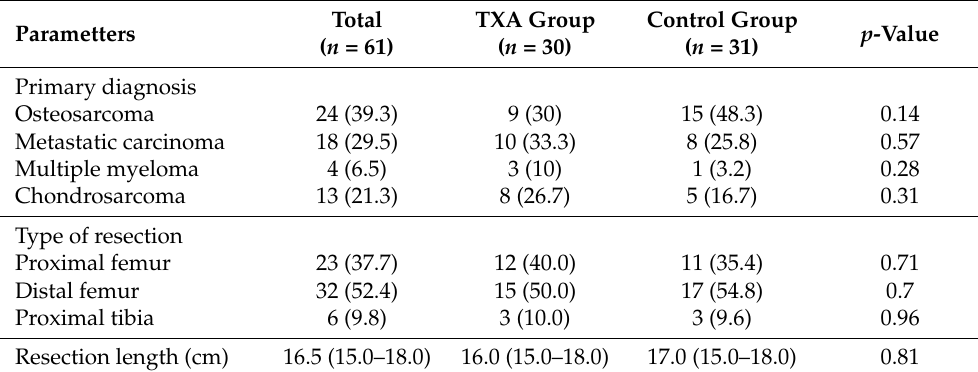
Table 1. Tumor characteristics and surgical parameters of the study